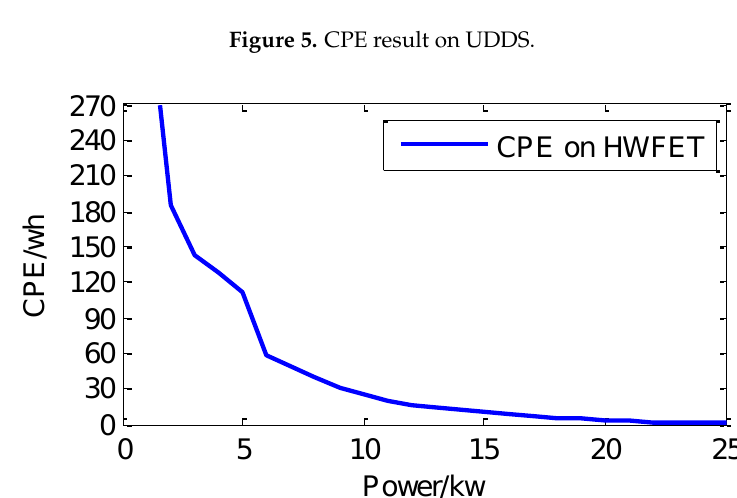
Figure 6. CPE result on HWFET.